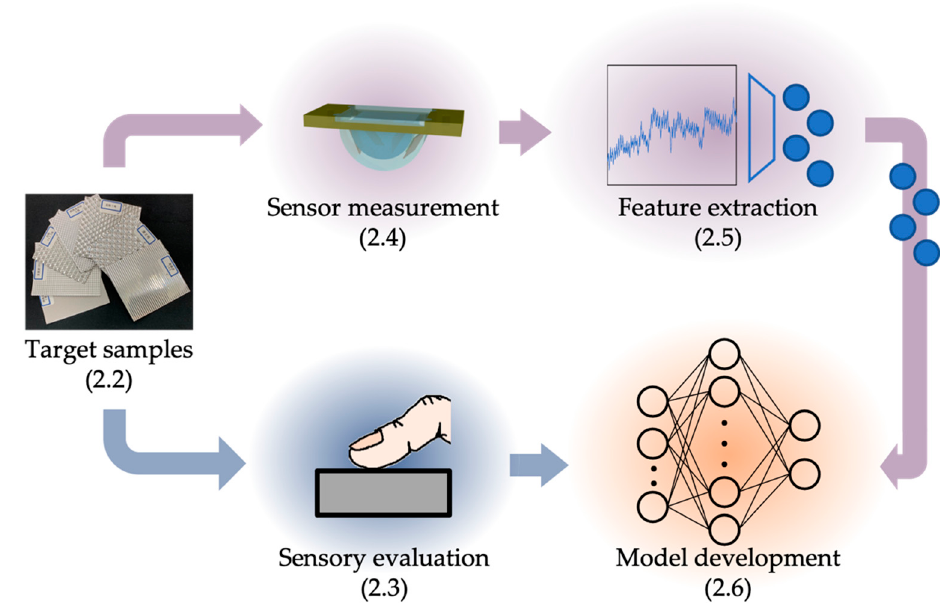
Figure 1. Strategy for developing a tactile estimation model. The number in parenthesis for each item refers to the section in which the item is described, (Section 2.2) target samples, (Section 2.3) sensory evaluation of samples, (Section 2.4) tactile sensing system and experimental conditions, (Section 2.5) feature extraction for the data acquired by the autoencoder, and (Section 2.6) establishment of a tactile estimation model through machine learning.